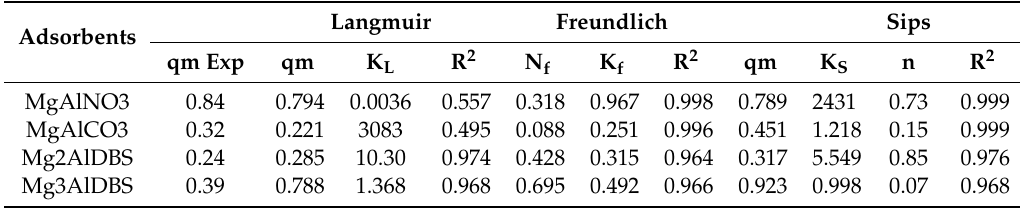
Table 5. Parameters of Langmuir and Freundlich and Sips models of DGB adsorption by MgAlNO3, MgAlCO3, Mg2AlDBS and Mg3AlDBS.